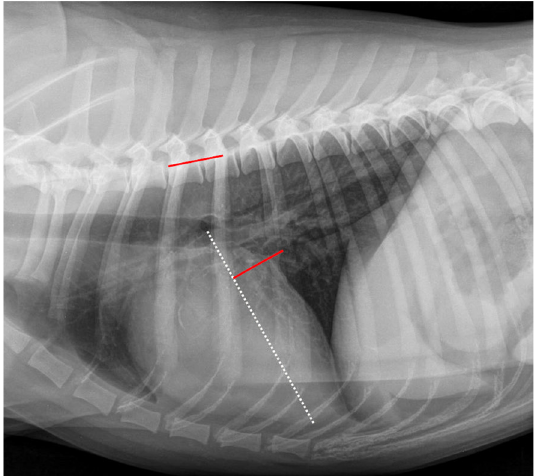
Figure 3. Measurement example of LA Width. The Left Atrial Width (LA Width ) measurement in the same right lateral thoracic radiograph is shown in Figure 1. The long axis was measured as described in Figure 1 (white dotted line). The short axis was drawn at a 90° angle to the long axis at the height of the dorsal intersection between the cardiac silhouette and the caudal vena cava (red line on cardiac silhouette). This line was repositioned onto the vertebral column (red line on vertebral) as described in Figure 1. The LA Width was 1.6 vertebral